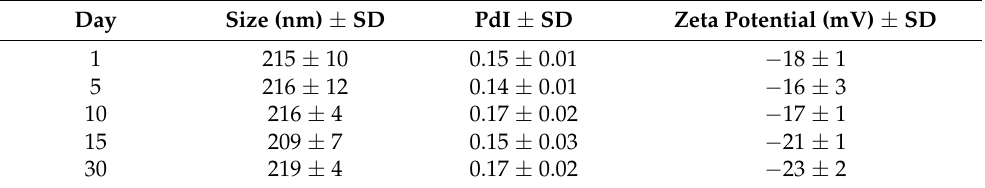
Figure 2. A Fourier-transform infrared spectroscopy (FTIR) evaluation of CopNc and each separate component of the system. ( A ): A Tween 80 ® spectrum; ( B ): a Span 60 ® spectrum; ( C ): a PCL spectrum; ( D ): an unloaded-CopNc spectrum; and ( E ): a CopNc spectrum. Table 2. Stability assessment of copaiba oil nanocapsules stored at room temperature (25 ± 2 ◦ C) over 30